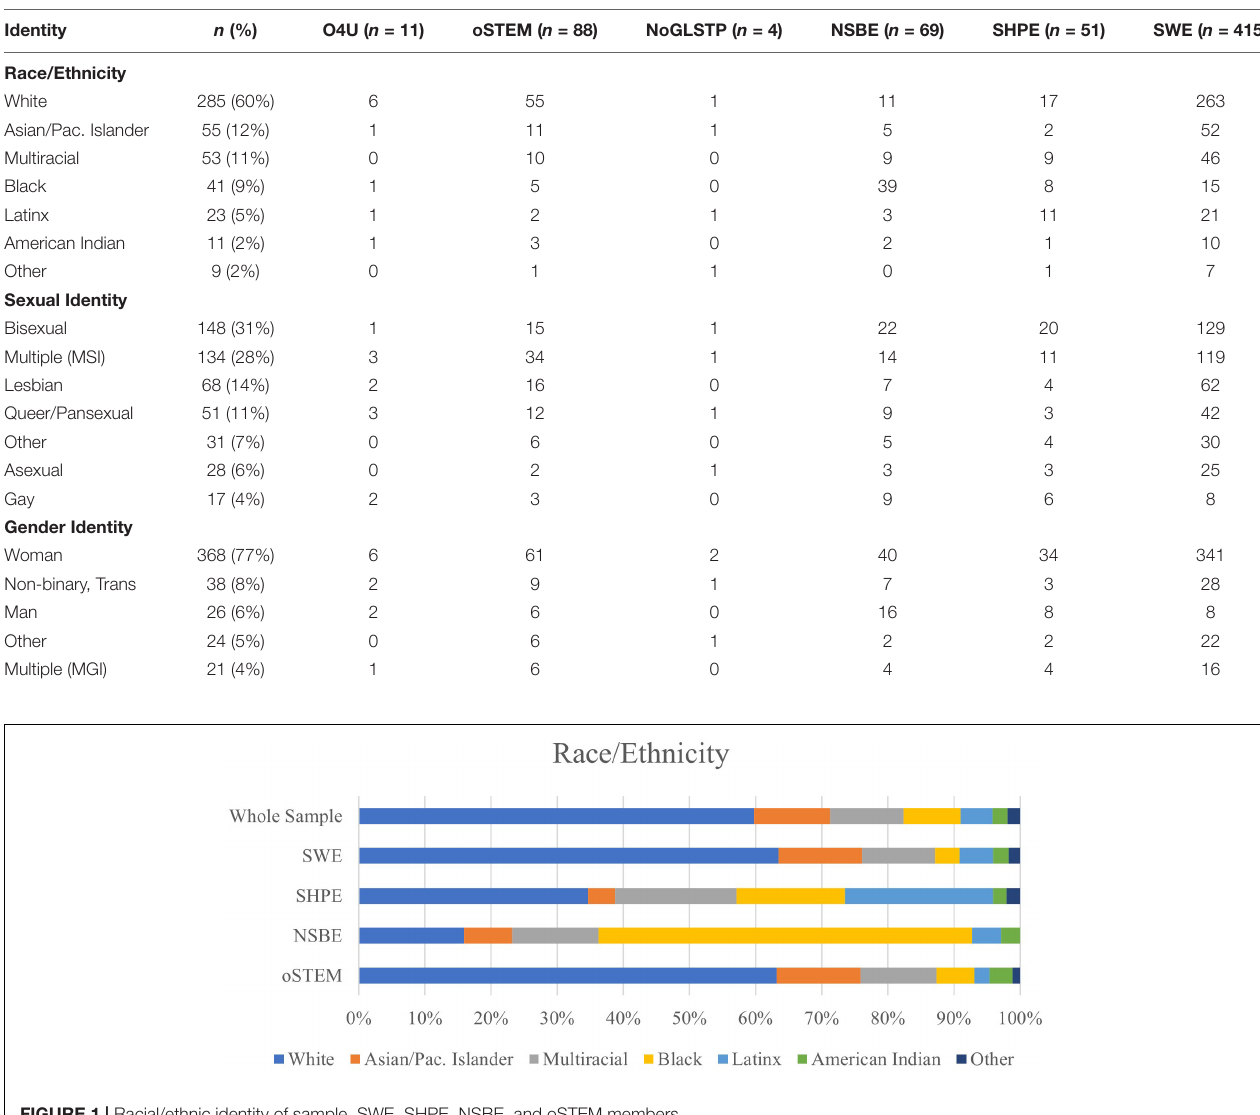
TABLE 2 | Organization participation by race/ethnicity, sexual identity, gender identity ( N = 477).